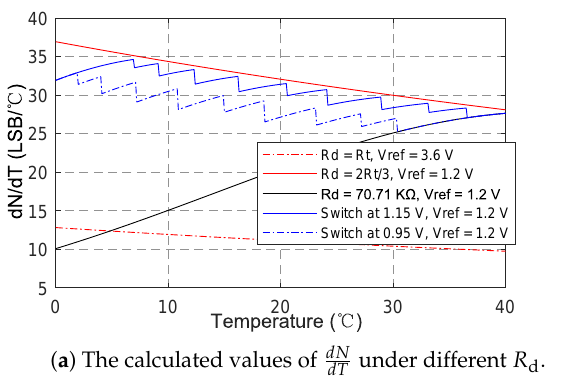
( b ) The AD sampling results and calculated tem- perature. Figure 7. The verification of voltage divider with controllable resistors.